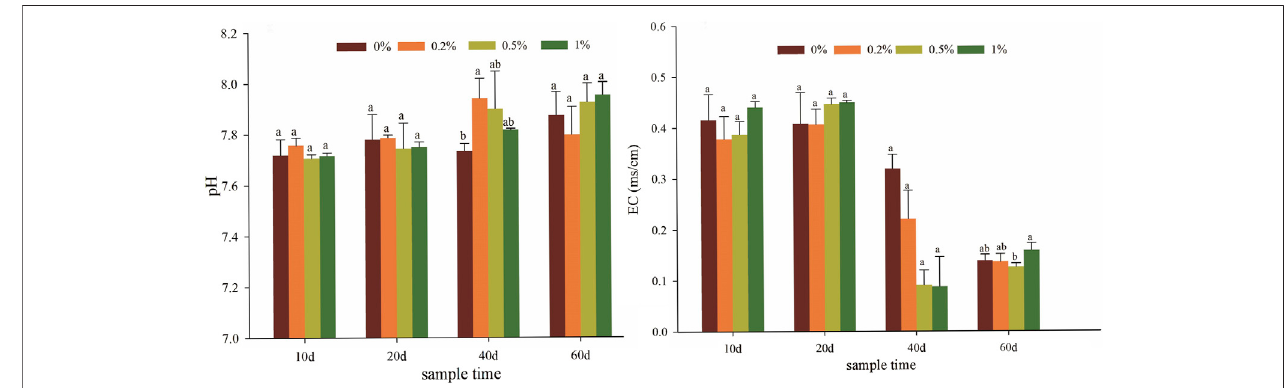
FIGURE 1 | Effects of soil pH (A) and EC (B) under various NMMT treatments. Mean values denoted by the same letter in a column do not differ signi fi cantly according to the Duncan test ( p < 0.05).